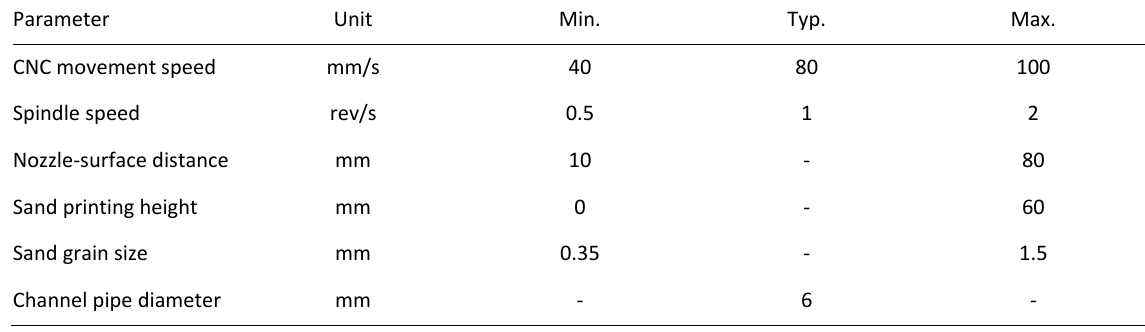
Table 1: Process parameters.